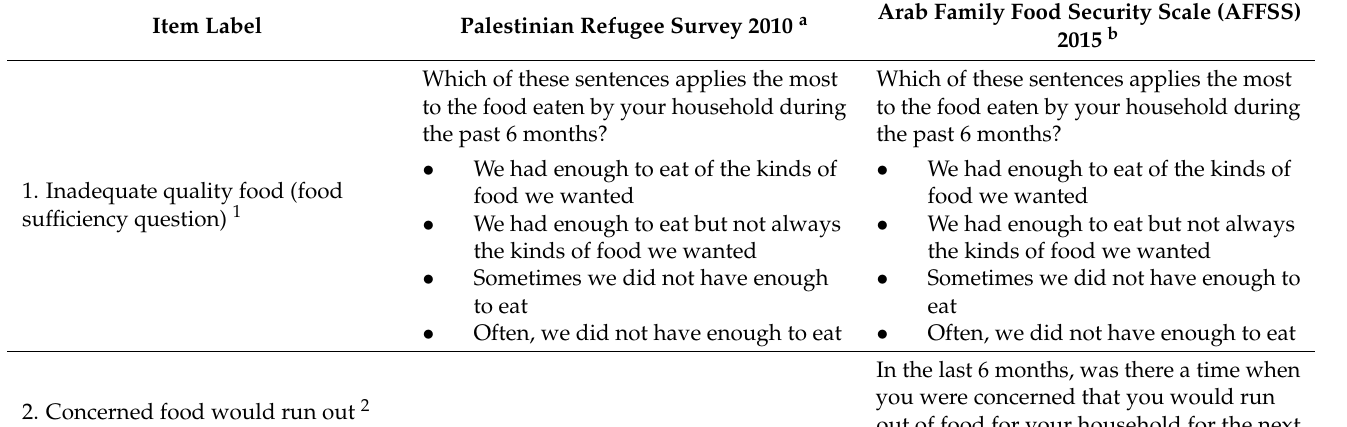
Table 1. Measurement tools used to assess food security (FS) among Palestinian refugees in the 2010 and 2015 Socio-Economic Surveys of Palestinian Refugees in Lebanon